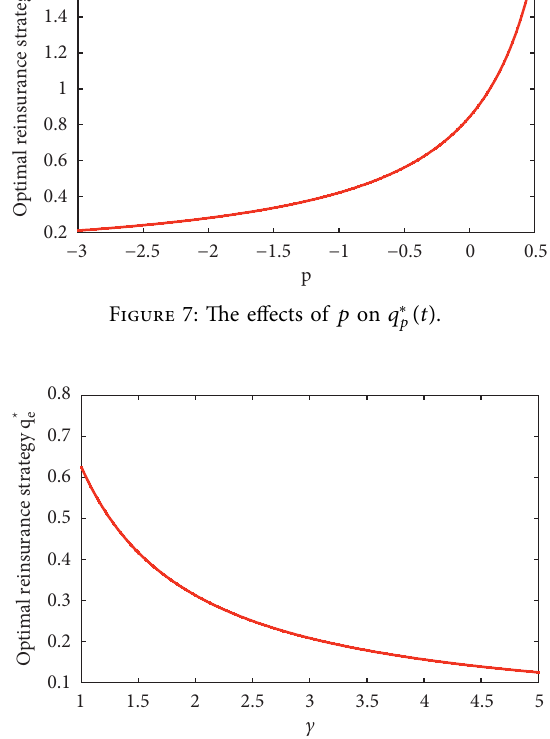
Figure 8: The effects of c on q ∗